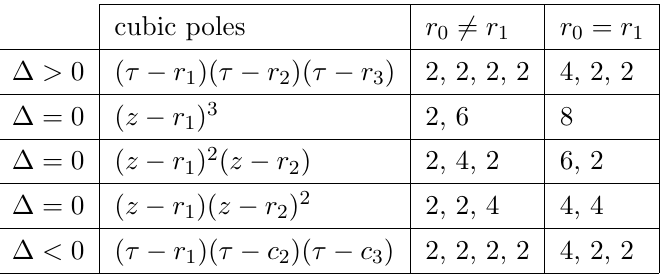
Table 2. The orders of the poles of V ( (cid:28) ), depending on both the determinant (cid:1) of the cubic polynomial in the denominator, and on whether the additional root r 0 coincides with one of the roots of the cubic polynomial or